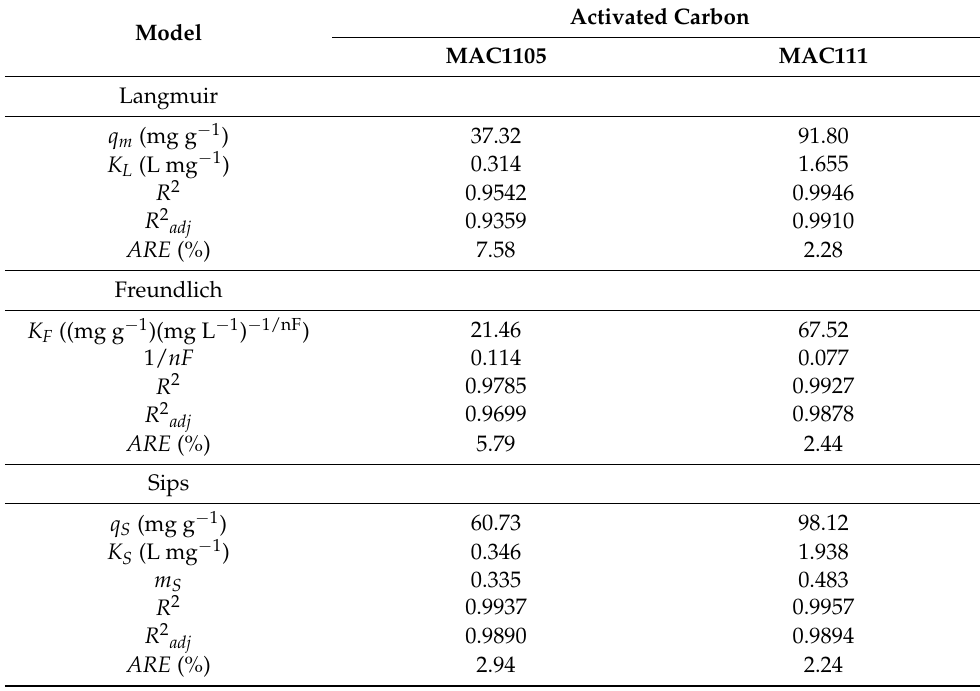
Figure 8. Equilibrium isotherms of BB blue dye adsorption onto ( a ) MAC1105 and ( b ) MAC111. Langmuir, Freundlich, and Sips models were used to interpret the equilibrium curves. Table 4 shows the equilibrium parameters. Based on the R 2 , R 2 adj , and ARE values, it is possible to observe that only the Sips model adequately represents the equilibrium data for MAC1105. On the other hand, for MAC111, all three models presented a good fit. However, the Sips model presented slightly higher R 2 and R 2 adj values and a slightly lower ARE value. Therefore, the experimental equilibrium data for both MACs established that the Sips model was the best choice. Table 4. Equilibrium parameters for the adsorption of BB dye.